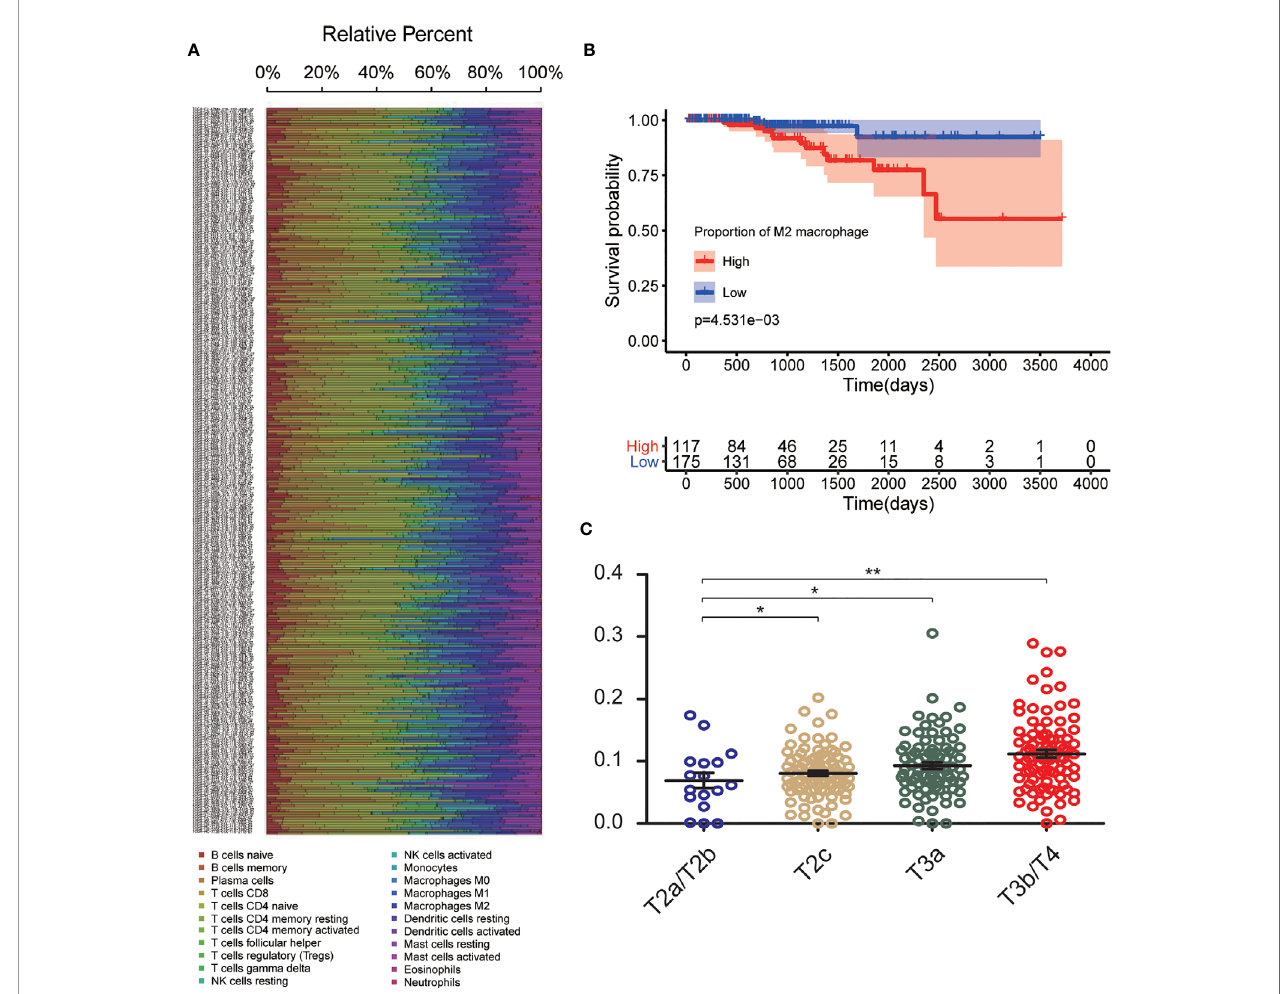
FIGURE 2 | CIBERSORT analysis and clinical signi fi cance of M2-TAMs in PCa. (A) Relative percent of each type of immune cell in 292 PCa samples from TCGA cohort; (B) Proportion of M2-TAMs in different stages; (C) Overall survival between patients with high and low proportion of in fi ltrated M2-TAMs. *P < 0.05; **P < 0.01.